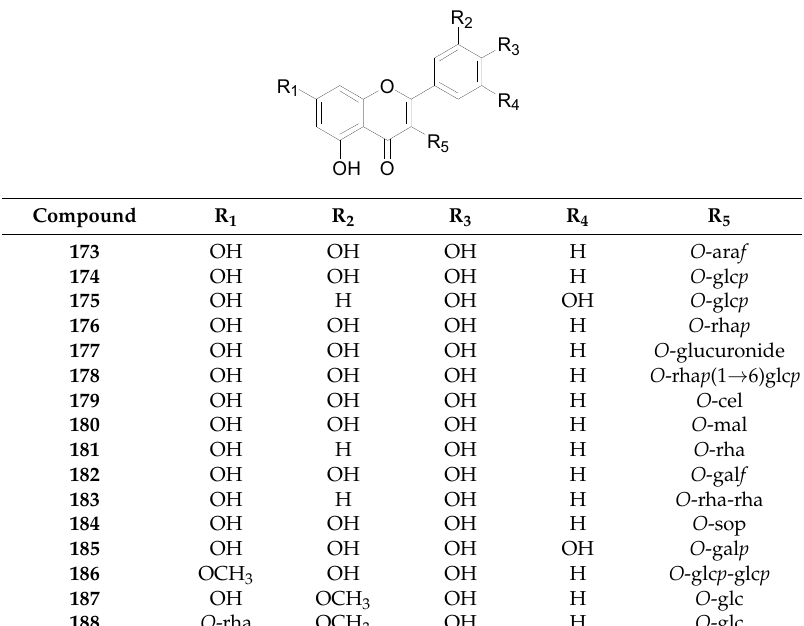
Table 12. Structures of compounds 173 – 188 .